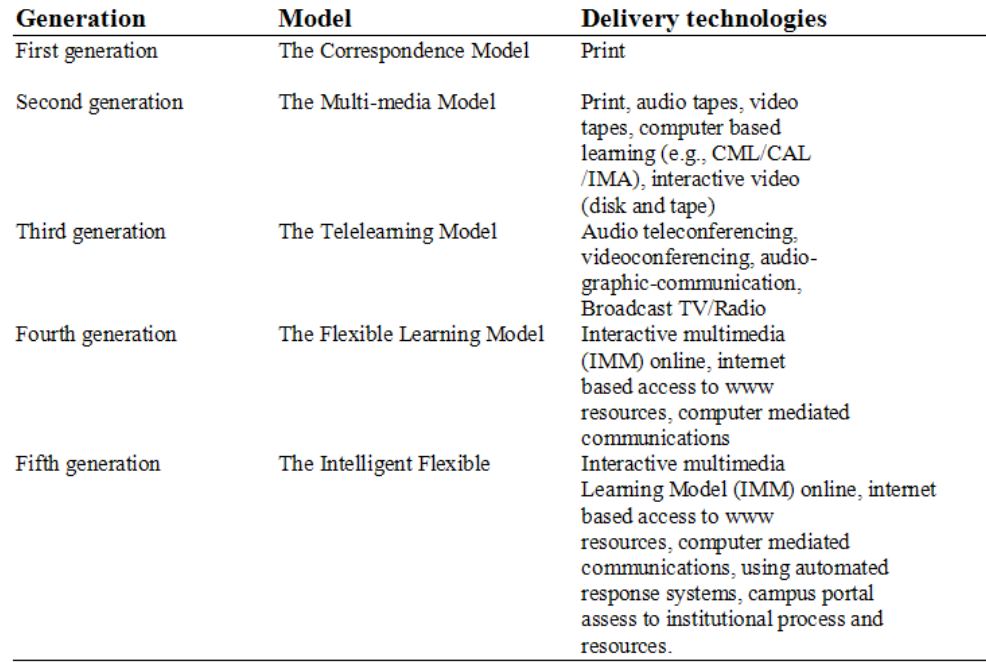
Table 4. Generations of Distance